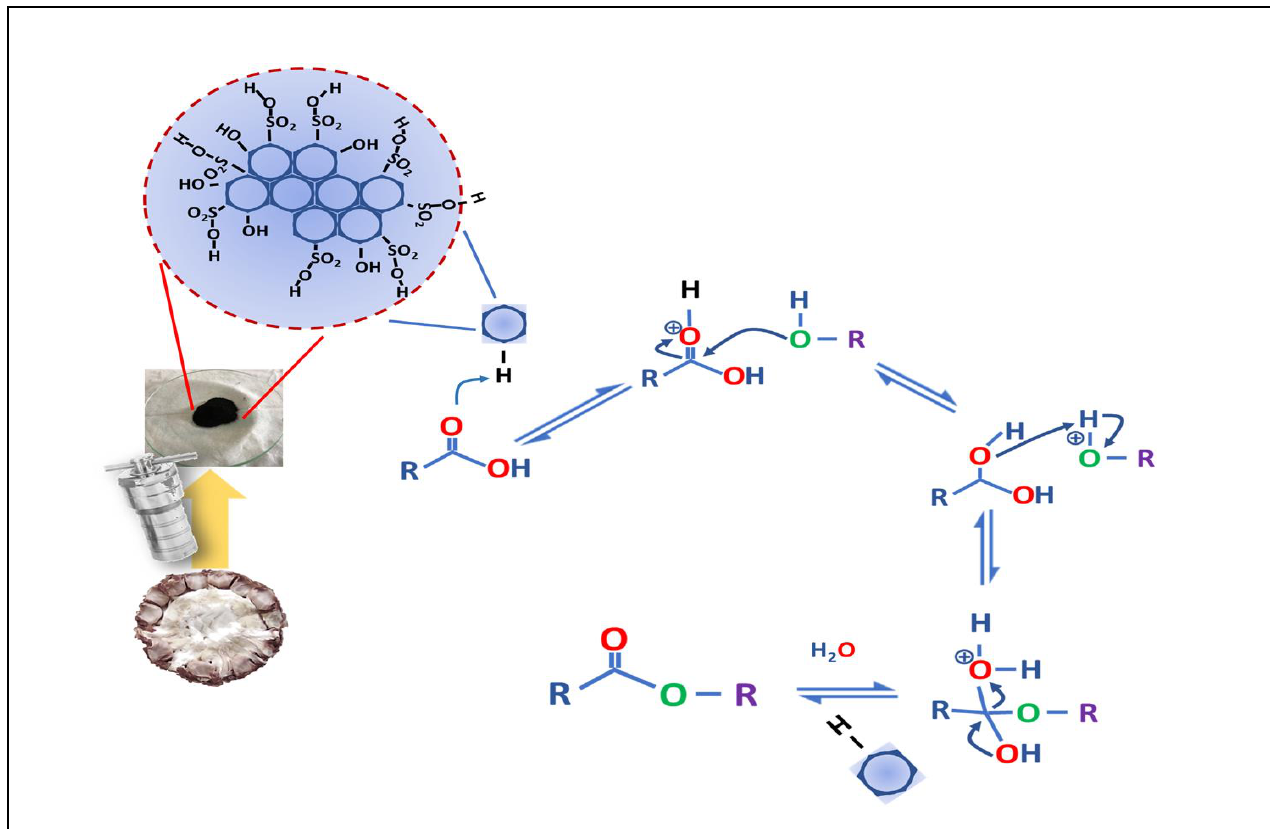
Fig. 4. Proposed mechanism pathways for esterification reaction using corncob derived sulfonated solid